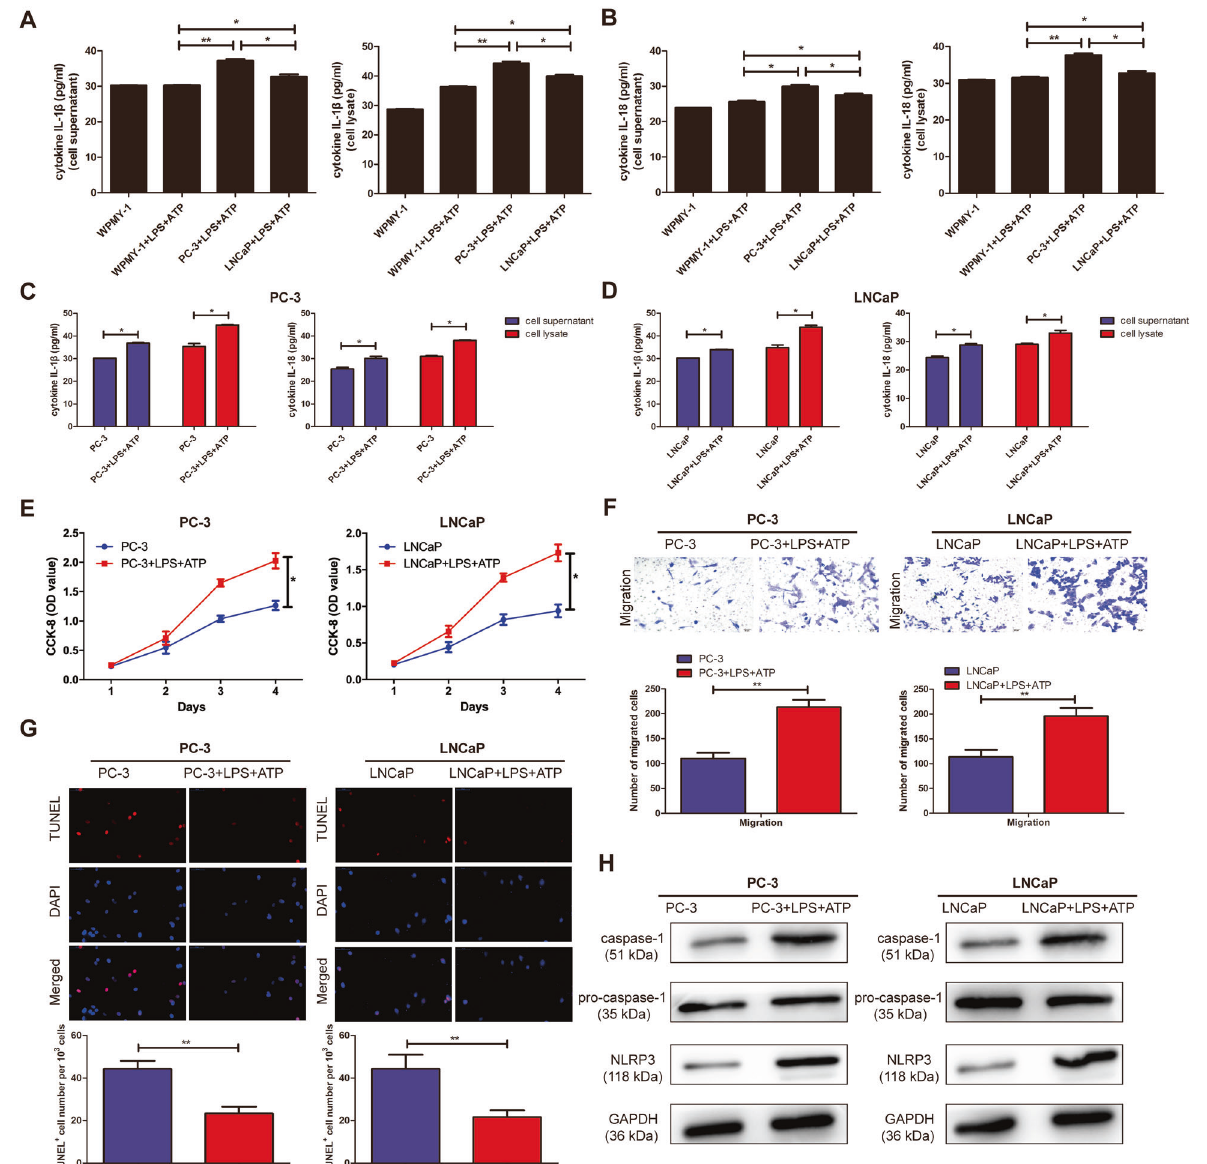
Fig. 2 The effects of LPS and ATP on the activation of NLRP3 in fl ammasome in PC3 and LNCaP cell lines. A The concentration of cleaved IL- 1 β in culture supernatants and lysate were signi fi cantly elevated in PC3 cell lines by stimulation of LPS + ATP, not in WPMY-1. B The concentration of cleaved IL-18 in culture supernatants and lysate were signi fi cantly elevated in LNCaP cell lines by stimulation of LPS + ATP, not in WPMY-1. C The expression of IL-1 β and IL-18 in the supernatant and lysate of PC3 cell lines were signi fi cantly elevated in LPS + ATP group, not in LPS or ATP alone group. D The expression of IL-1 β and IL-18 in the supernatant and lysate of LNCaP cell lines were signi fi cantly elevated in LPS + ATP group, not in LPS or ATP alone group. E CCK-8 assay detected the proliferation of PCa cell lines in the stimulation of LPS + ATP. F Transwell assay was used to detect the migration ability after the stimulation of LPS + ATP in PC3 and LNCaP cells (magni fi cation: ×40). G TUNEL assay was used to detect the apoptosis after the stimulation of LPS + ATP in PC3 and LNCaP cells (magni fi cation: ×40). H Western Blot was used to detect the expression level of NLRP3 and caspase-1 after the stimulation of LPS + ATP in PC3 and LNCaP cells. Data are mean ± SD. Scale bar, 20 µm. * p < 0.05, ** p <